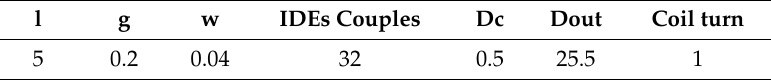
Table 2. Dimension parameters of MoS2 humidity